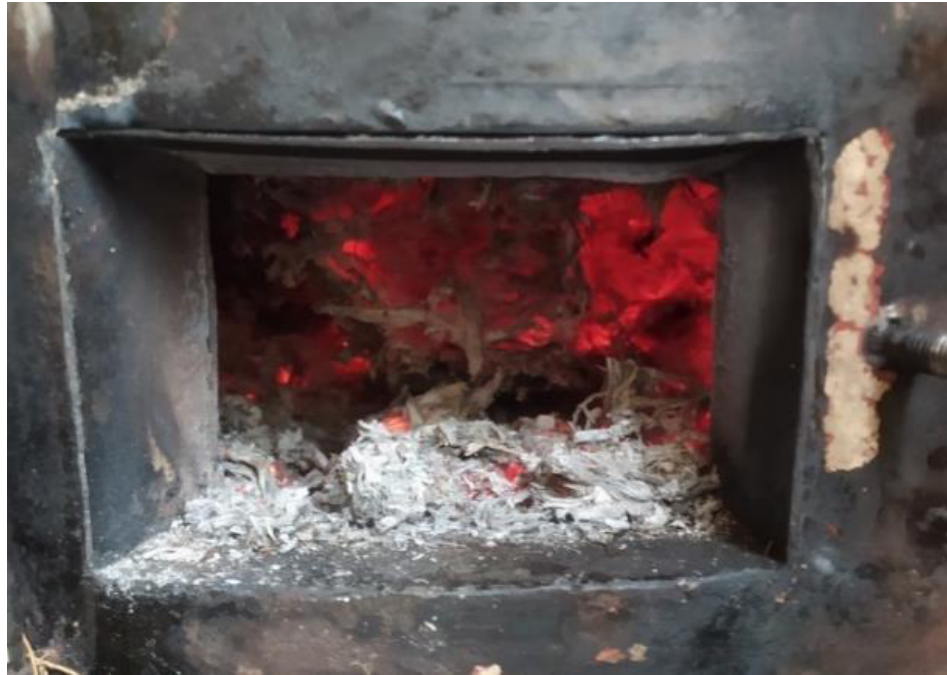
Figure 7. Residual ashes after the burning process.